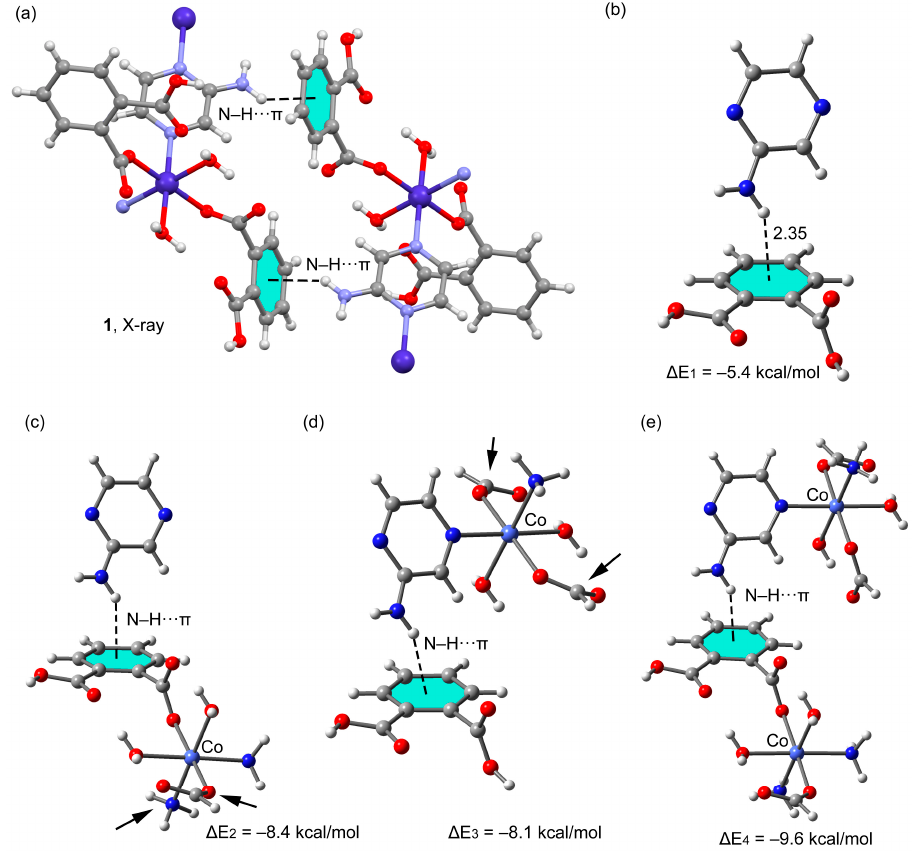
Figure 5. ( a ) X-ray fragment of compound 1 . ( b – e ) Theoretical models used to estimate the effect